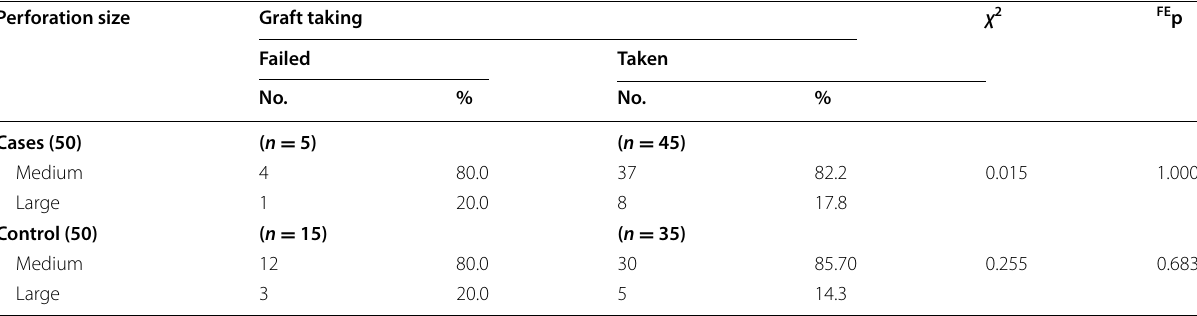
χ 2 chi-square test, FE Fisher exact test, p p